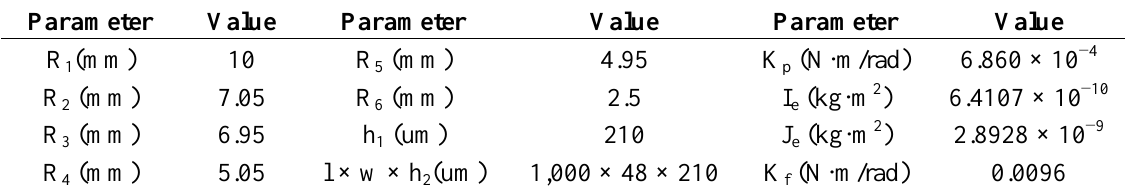
Table 1. The structure parameters.